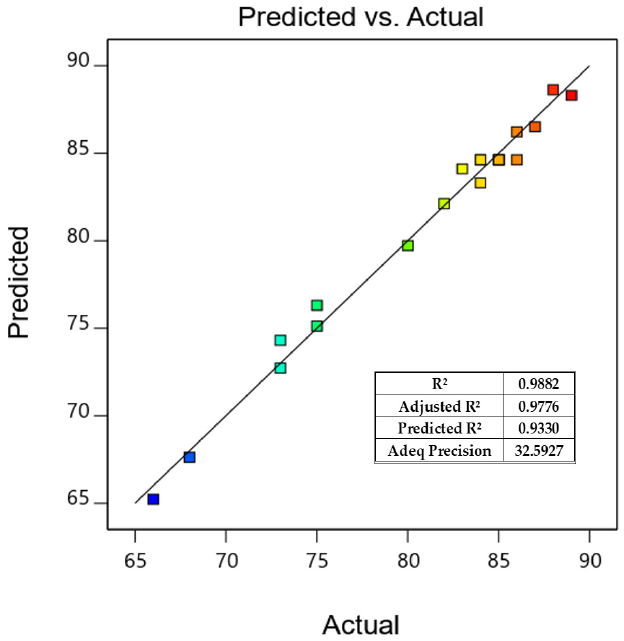
Figure 5. Predicted vs. actual plots for gold leaching. To elucidate the correlation among the variables on the leaching of gold, 3D response surface plots and 2D contour plots were drawn as shown in Figure 6. These depict the in- crease in leaching efficiency of gold with longer residence time and stirring speed. However, as the temperature increases, the gold leaching efficiency increases until 70 ◦ C and then decreases. This could be attributed to the evaporation of bromine at higher temperatures. The blue zone indicates lower leaching, and the red zone denotes the highest, as shown in Figure 7. However, the numerical optimization of parameters of RSM was also chosen